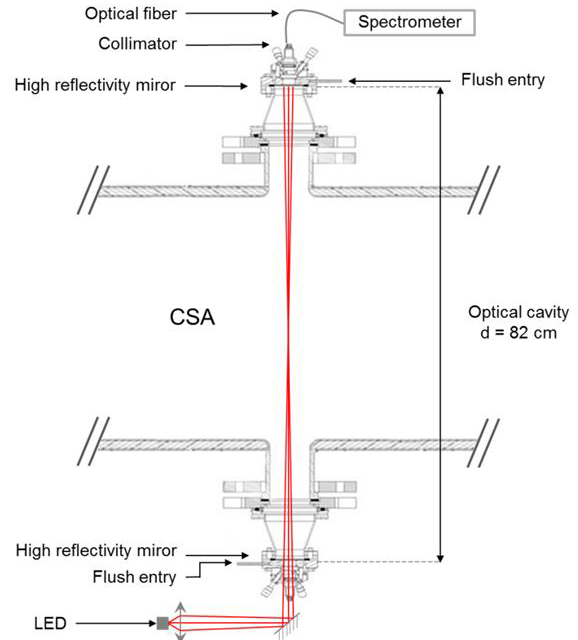
Figure 1. Scheme (transverse section) of the IBBCEAS instrument interfaced to the CSA chamber. Collimating lenses and curved mir- rors are not shown on the beam injection